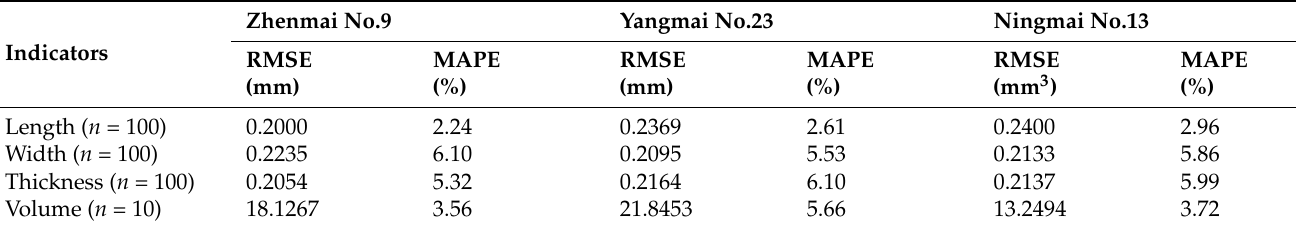
Table 2. Three varieties measurement